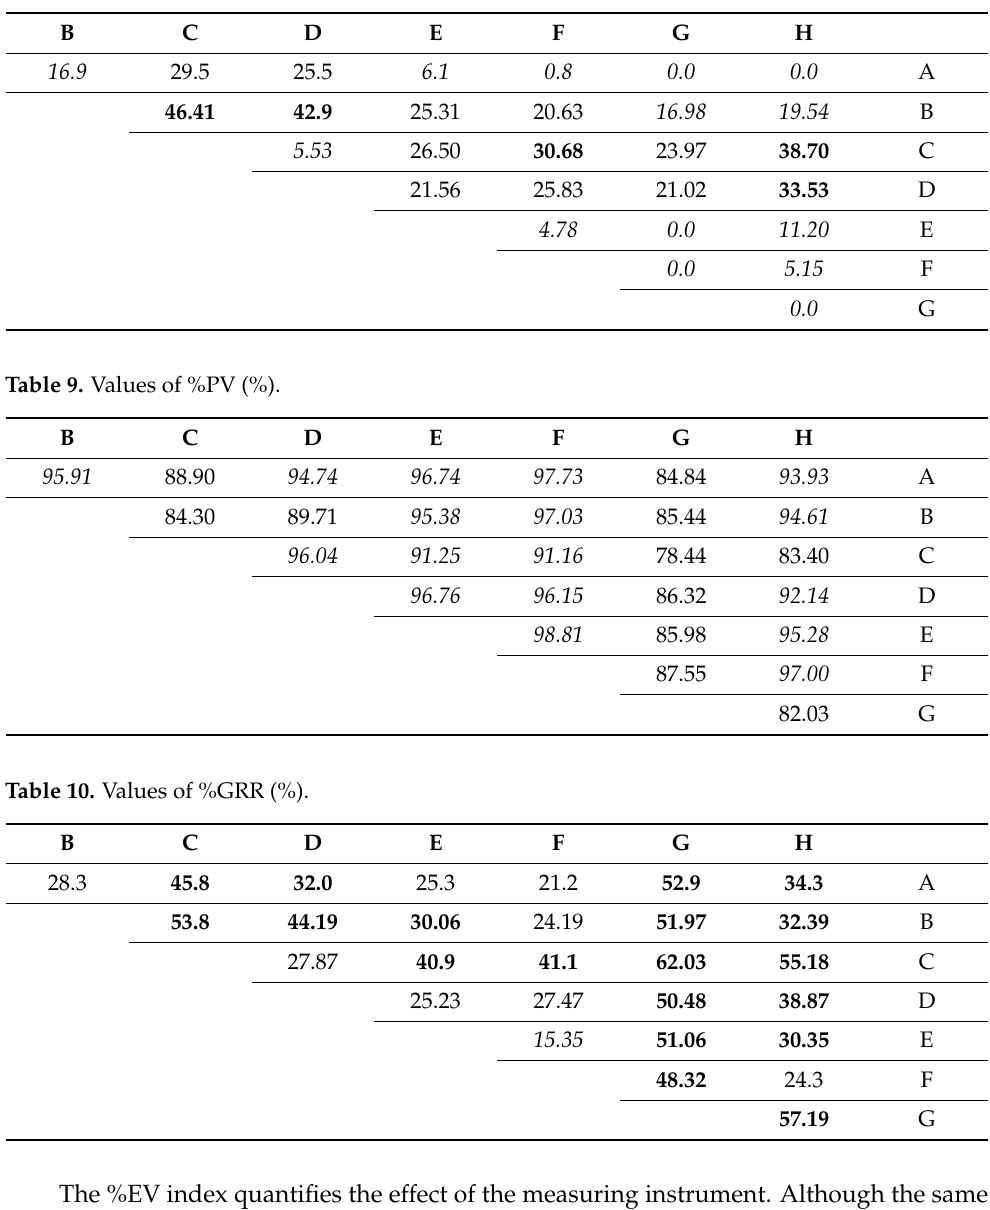
Table 8. Values of %AV (%).